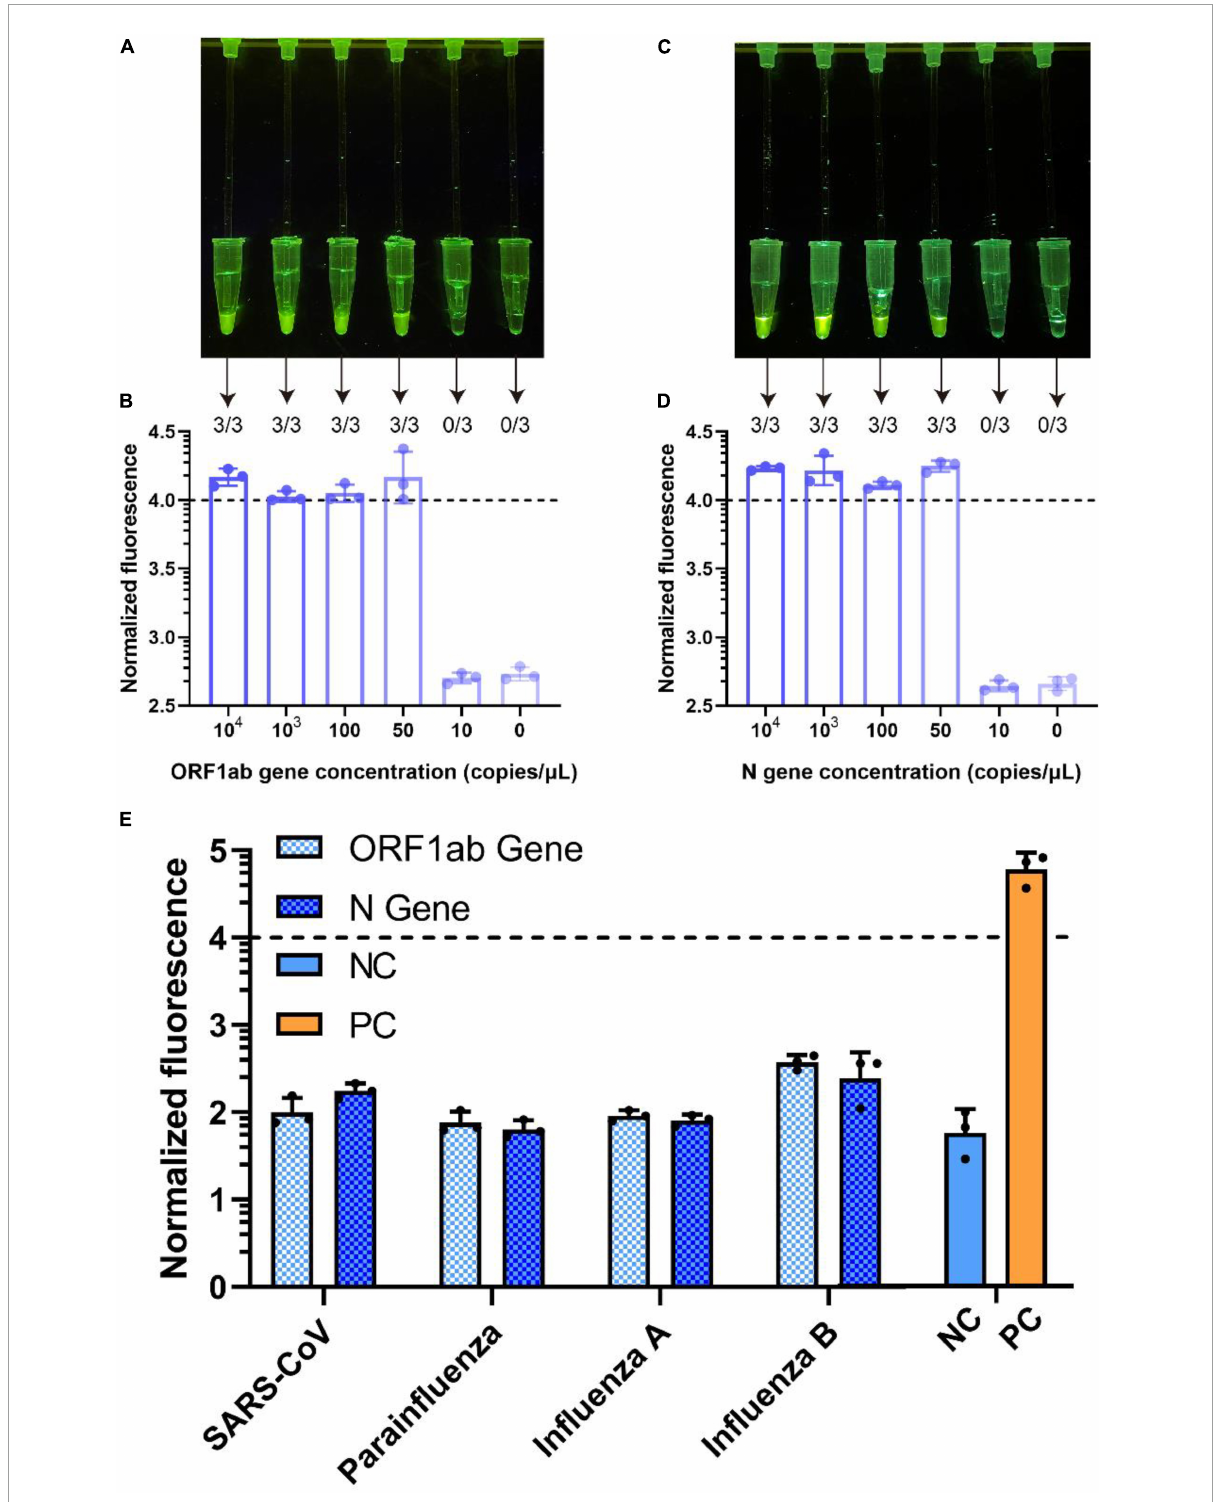
FIGURE4 Limit of detection and specificity of the reaction system. The LOD of the ORF1ab gene [ (A) , visual detection; (B) , fluorescence detection]. The LOD of the N gene [ (C) , visual detection; (D) , fluorescence detection]. All examinations were performed in triplicate. Four pathogen standards were used to detect the specificity of the integrated assay (E) . The orange line is the positive control, which is the only one above cutoff value (4.0). The fluorescence intensity of the reaction was normalized, bar represent mean ±